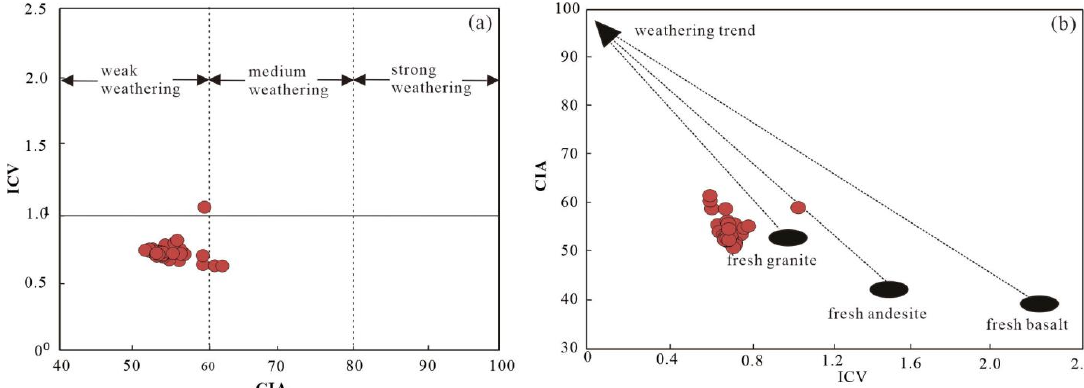
Figure 8. Sandstones of the Sifangtai Formation in the northwest of Songliao Basin, ( a ) CIA-ICV diagram, ( b ) ICV-CIA diagrams (modified after Cox et al. [40]).